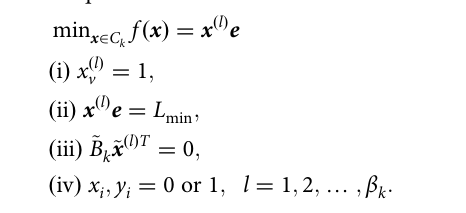
Algorithm 1 . Searching speci fi c cycles ( x * = Find Cycle ( B k , v ,